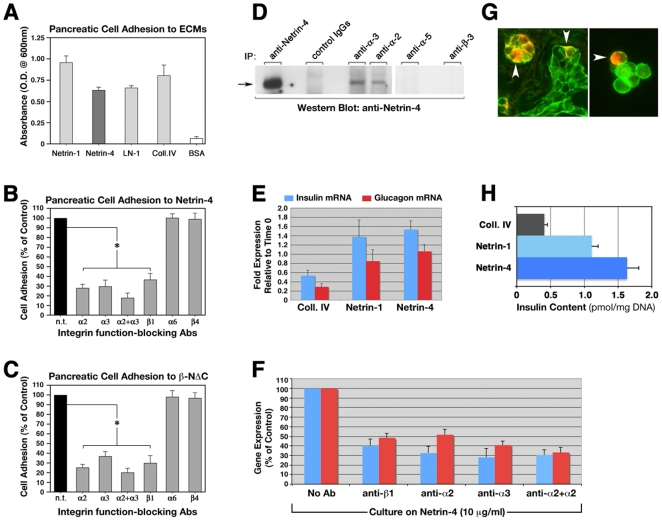
Netrin-4 supports epithelial cell adhesion through integrin receptors and fosters the expression of islet-specific differentiation genes.(A) Adhesion of pancreatic epithelial cells to Netrin-1, Netrin-4, LN-1 and Collagen IV. BSA was used as negative control. (B) Cell adhesion to Netrin-4 in the absence (n.t., no treatment) or presence of function-blocking antibodies to select integrin subunits. Note the significant blockade of cell attachment to Netrin-4 in the presence of anti-α2, -α3, -β1, or a combination of anti-α2 and anti α3 function-blocking antibodies. (C) Similar results were obtained when cells were plated on a modified recombinant Netrin-4 (ΔC-Netrin-4) that lacks 155aa from its carboxy terminal domain. Data in A and B are representative of n = 4, and in C of n = 3. *p<0.001 ANOVA followed by post-test Bonferroni's multiple comparison test. (D) Immunoprecipitation using anti-Netrin-4, -α2, -α3, -α5, -β3 or control IgGs, followed by Western blotting for Netrin-4 revels that α2 and α3, but not α5 or β3, integrin subunits selectively interacts with Netrin-4 in live cells. Representative of n = 3. (E) TaqMan PCR analysis for insulin and glucagon mRNAs demonstrates that overnight culture of embryonic pancreatic cells on Netrin-4 promotes the expression of these two islet-specific differentiation genes, when compared to Collagen IV. Culture on Netrin-1, that we reported to engage integrin α3β1 as a receptor [10], also revealed significantly higher levels of insulin- and glucagon-specific transcripts when compared to Collagen IV (n = 6); statistical significance of differences in insulin (p<0.001) and glucagon (p<0.005) expression between Netrins and Coll. IV overnight cultures was determined by ANOVA followed by post-test Bonferroni's multiple comparison test. (F) Blockade of α2, α3, β1, or α2 and α3 simultaneously, significantly reduced Netrin-mediated pro-differentiative effects on pancreatic cells (n = 4). (G) Specific immunoreactivity for the α3 integrin subunit (green fluorescence) is detected both in situ (G, left panel) and in vitro (G, right panel) in insulin-producing cells (red fluorescence, arrowheads). (H) Insulin content measured in embryonic pancreatic cells cultured on either Collagen IV, Netrin-1, or Netrin-4 (n = 4).